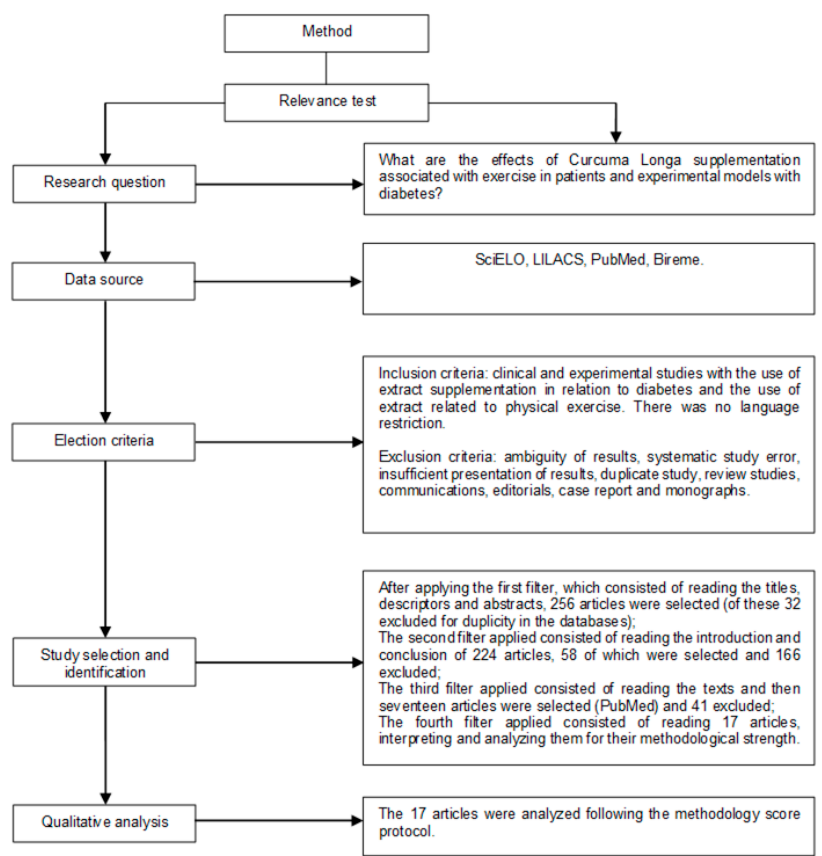
Figure 1. Research strategy flowchart and article selection.